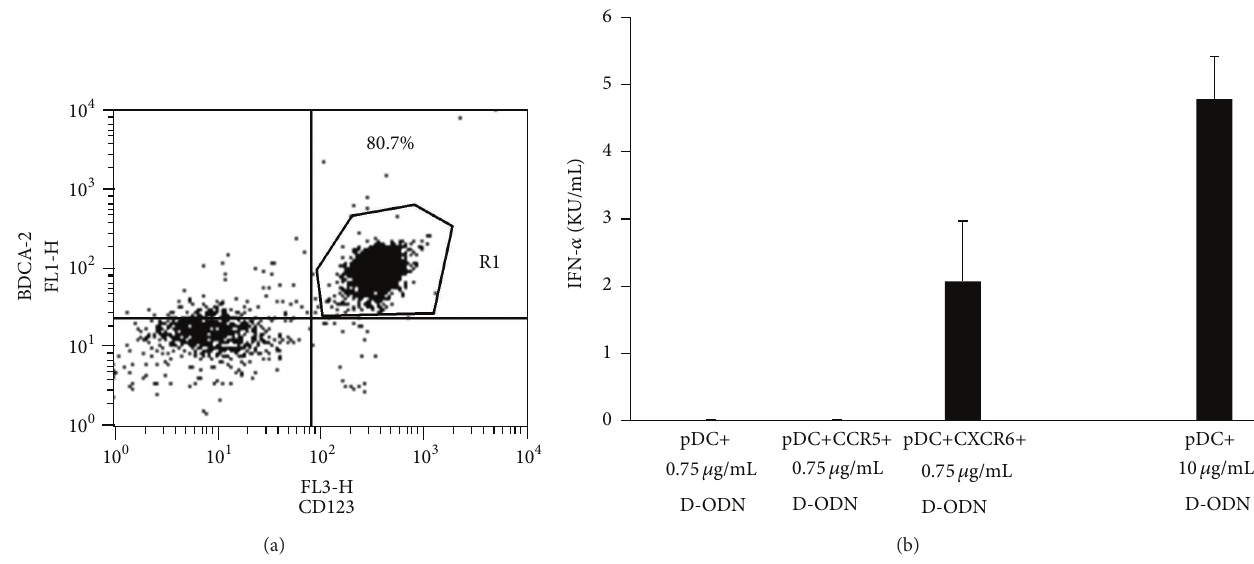
Figure 3: CXCL16/CXCR6 interaction reduces the threshold of activation in pDCs responding to D-ODN. (a) pDCs were enriched from human PBMCs using the BDCA-4 isolation kit as recommended by the manufacturer. Purity of cells was established by flow cytometry following staining with pDC associated cell-surface markers. (b) Enriched pDCs (100,000 cells/well) were incubated with CXCR6 or CCR5 expressing Jurkat T cells (1:1 ratio) in 96-well U-bottom plates. Cocultures were then stimulated with a suboptimal concentration of D- ODN (0.75 𝜇 g/mL). pDC stimulated with optimal concentration of D-ODN (10 𝜇 g/mL) served as a positive control. Cytokine production was assessed from culture supernatants 24 h later using ELISA. Average response of 3 different pDC preparations is shown (mean ±